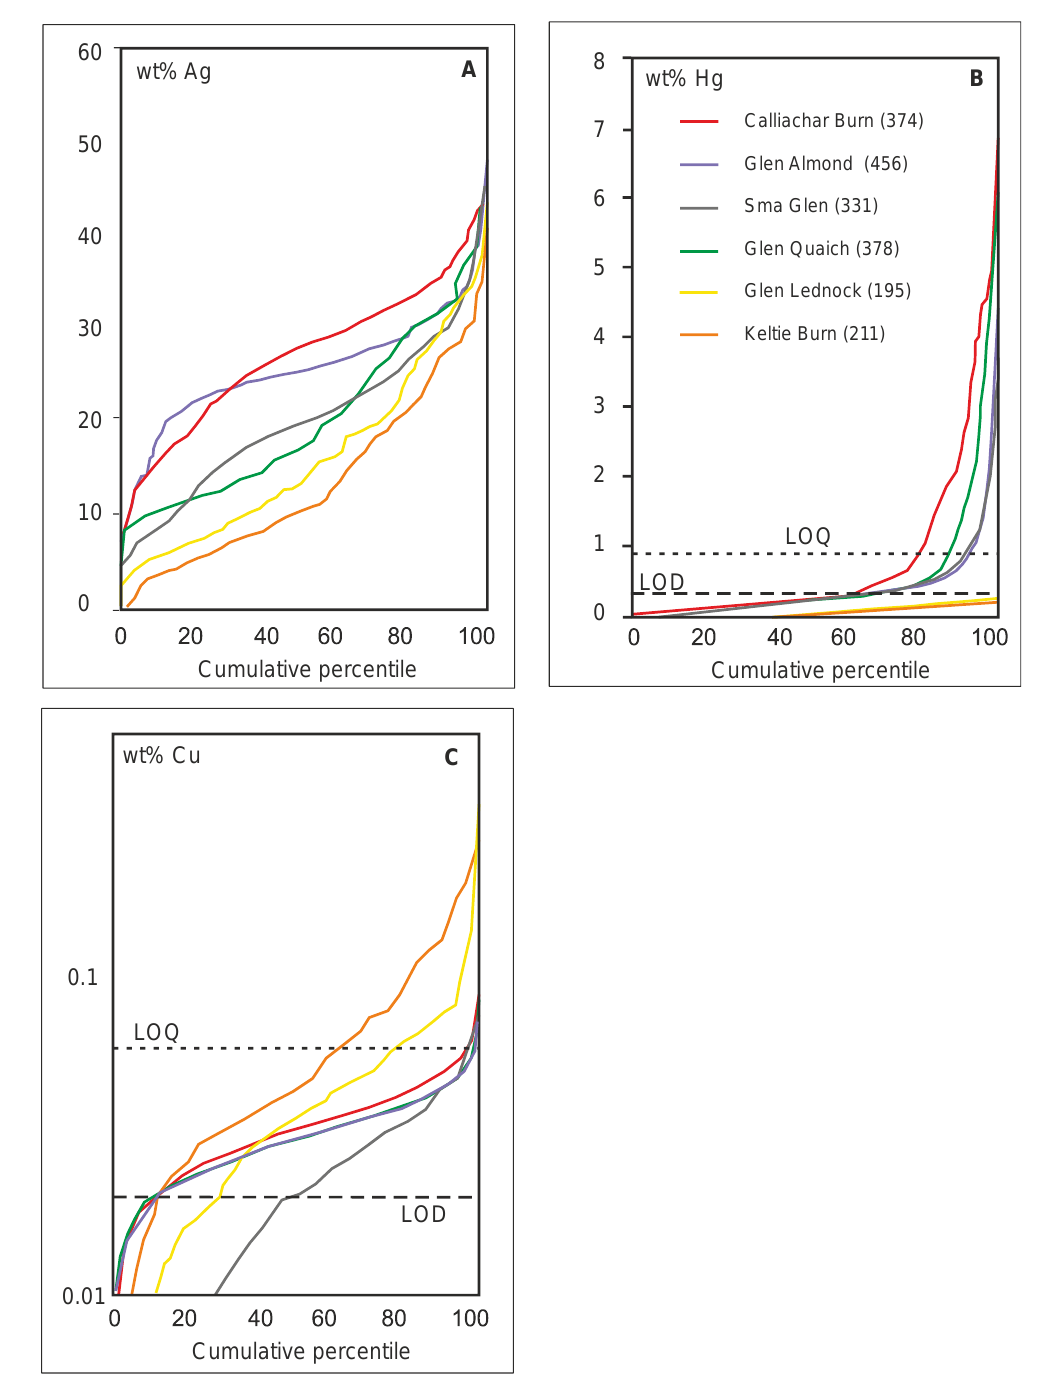
Figure 3. Gold alloy composition. ( A ) Silver content of Au-Ag alloys; ( B ) Mercury content of Au-Ag alloys; ( C ) Cu content of Au-Ag alloys. Note logarithmic scale for y axis of Cu plot. Figures in parentheses refer to number of particles in the sample population. Key in Figure 3B applies to all.